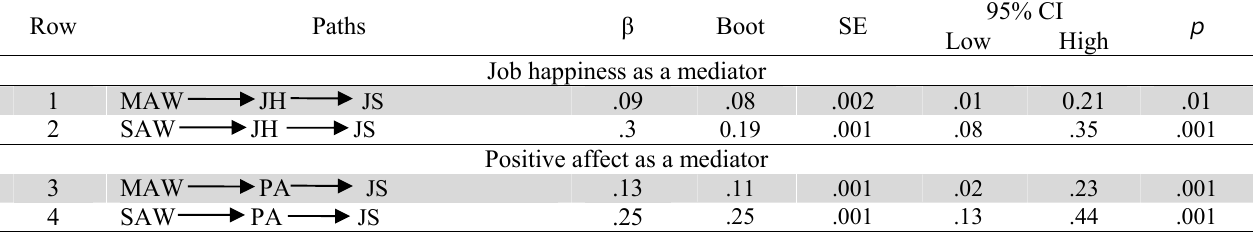
Bootstrap results of indirect effects in final and revised models of research Row Paths